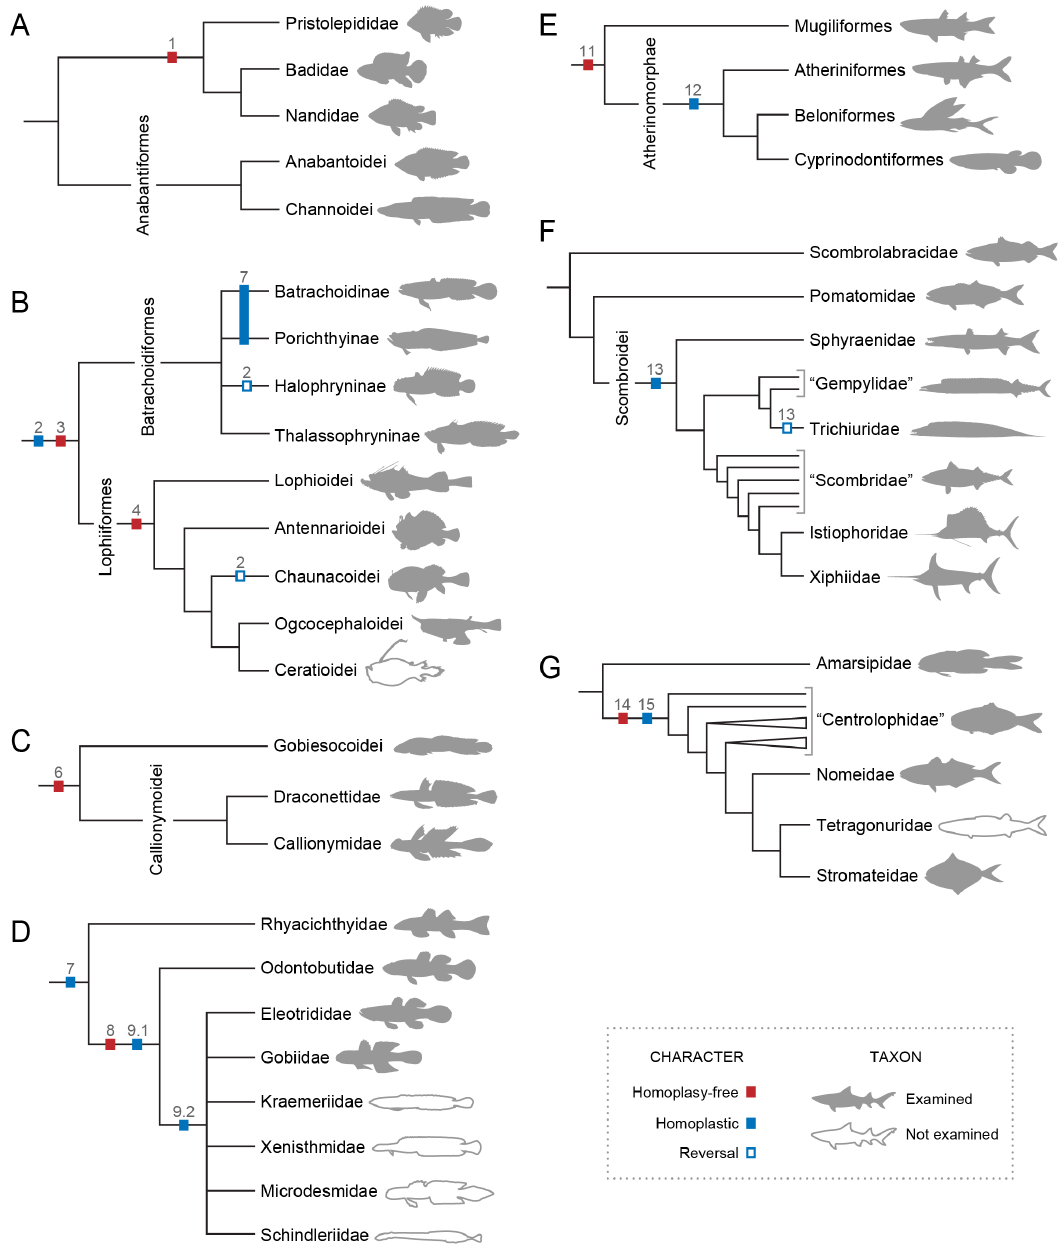
Figure 5. Maximum parsimony optimization (ACCTRAN) of the identified derived characters of the infrabranchial musculature. Characters superimposed on cladograms of the relationships among the (A) Anabantomorpha [8,117]; (B) Batrachoidiformes and Lophiiformes [53,54,63]; (C) Callionymoidei and Gobiesocoidei [44,66–68]; (D) Gobiiformes [76–78]; (E) Mugiliformes and Atherinomorphae [81,95]; (F) Scombroidei, Pomatomidae and Scombrolabracidae [98]; and (G) Stromateiformes [111]. Characters numbered as in the